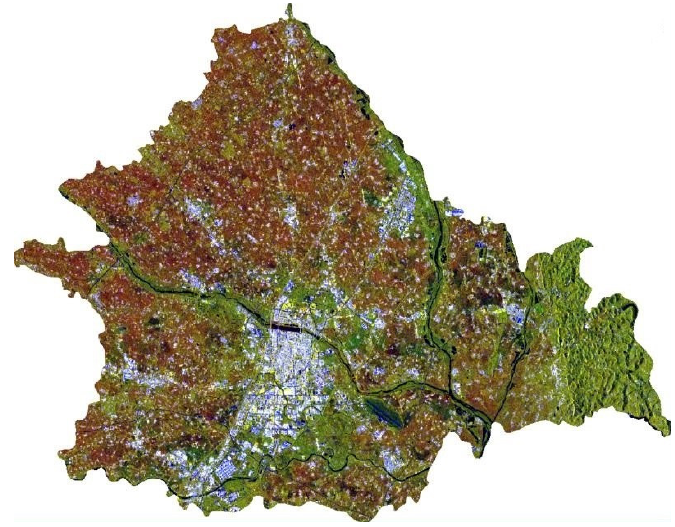
Figure 19. Multi-temporal and coherence coefficient RGB composite map.